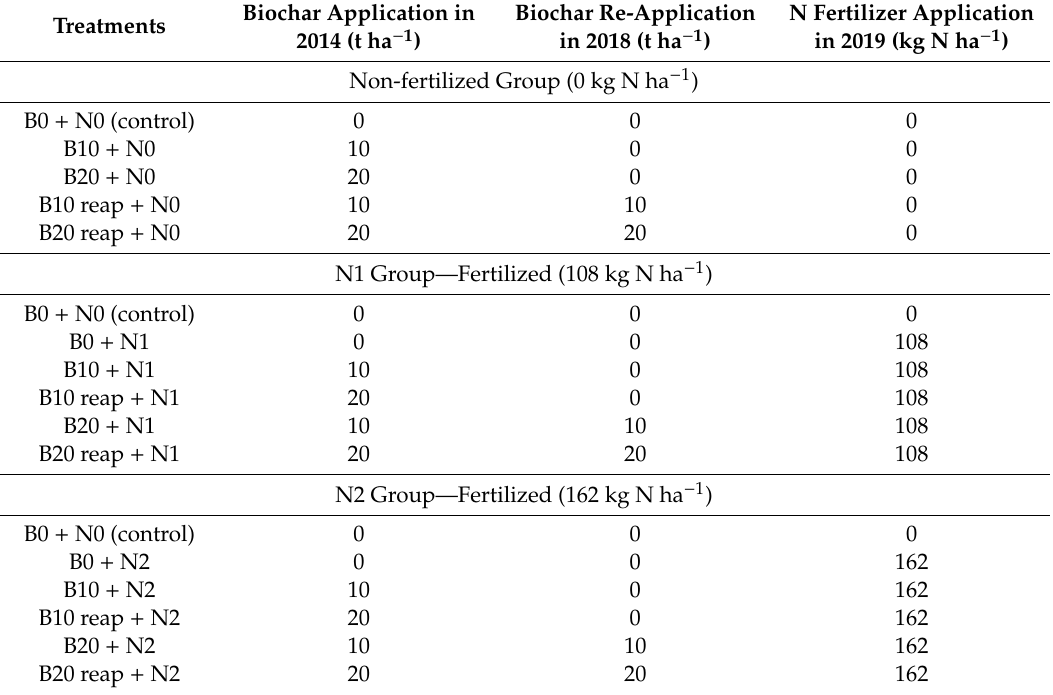
Table 1. Treatments of the field experiment with a dose of biochar and a dose of nitrogen fertilizer. Treatments